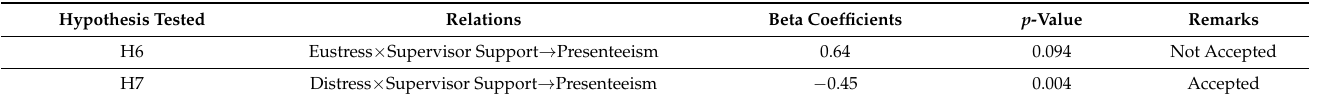
Table 7. Direct and indirect relations of study